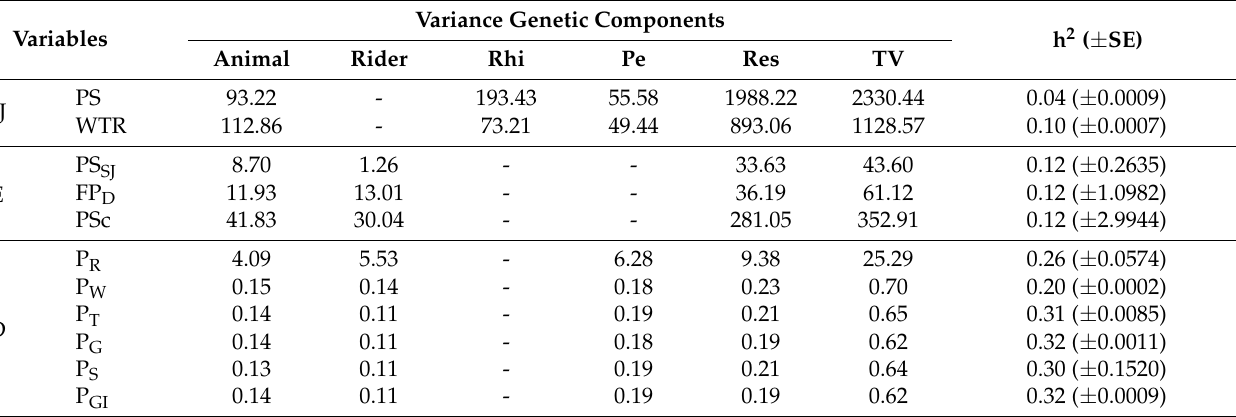
Table 2. Estimation of variance components and heritability (h2) for the genetic evaluations computed for Show Jumping (SJ), Eventing (E) and Dressage (D) disciplines. Variance Genetic Components Variables